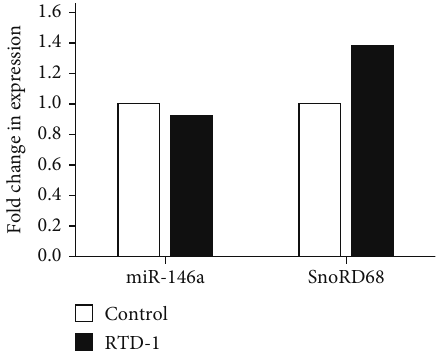
Figure 2: RTD-1 does not a ff ect miR-146a stability. THP-1 cells were incubated with 10 ng/ml LPS for 18 h to induce the expression of miR-146a. The cells were then washed and treated with vehicle or 10 μ g/ml RTD-1 for 4 h. The RNA was then analyzed by qRT-PCR for miR-146a and SnoRD68 expression after normalizing it to RNU6-2 expression. The average of the 2 experiments is shown. Fold change was calculated with respect to